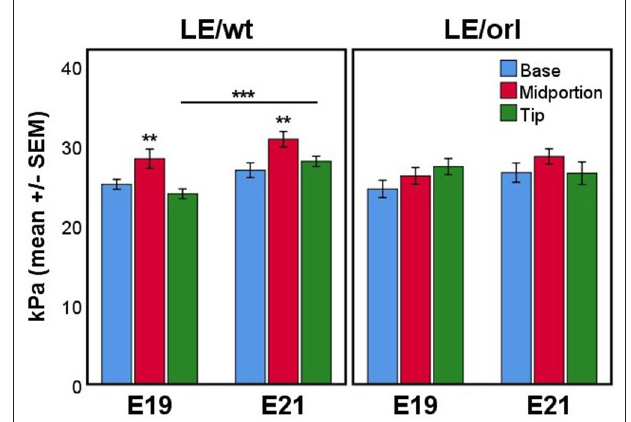
FIGURE 7 | (A) GAG concentrations in conditioned media from LE/wt gubernaculum membrane cultures show no differences between control and DHT-exposed samples (results expressed using a logarithmic scale; n = 2–3 per treatment group per time point). (B) Gubernaculum GAG